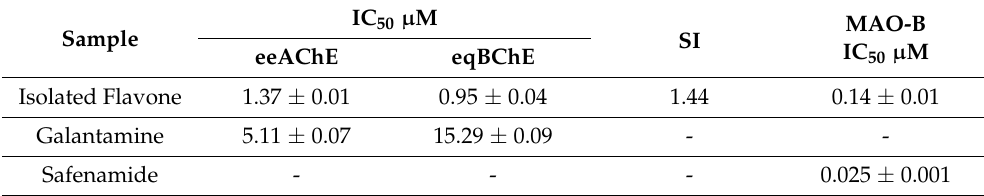
Table 1. Percent AChE, BChE and MAO-B inhibition activity of isolated flavone.